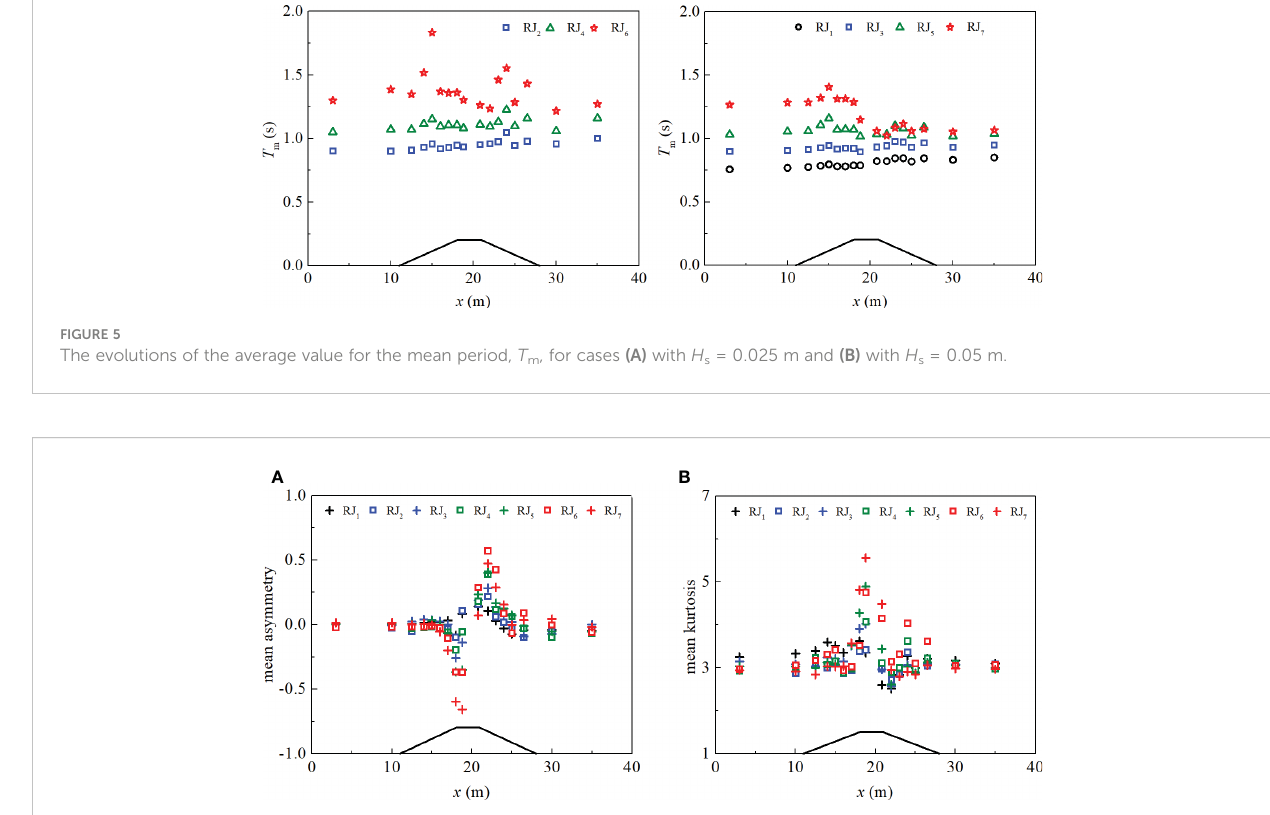
FIGURE 6 The evolutions of the mean asymmetry (A) and kurtosis (B) .